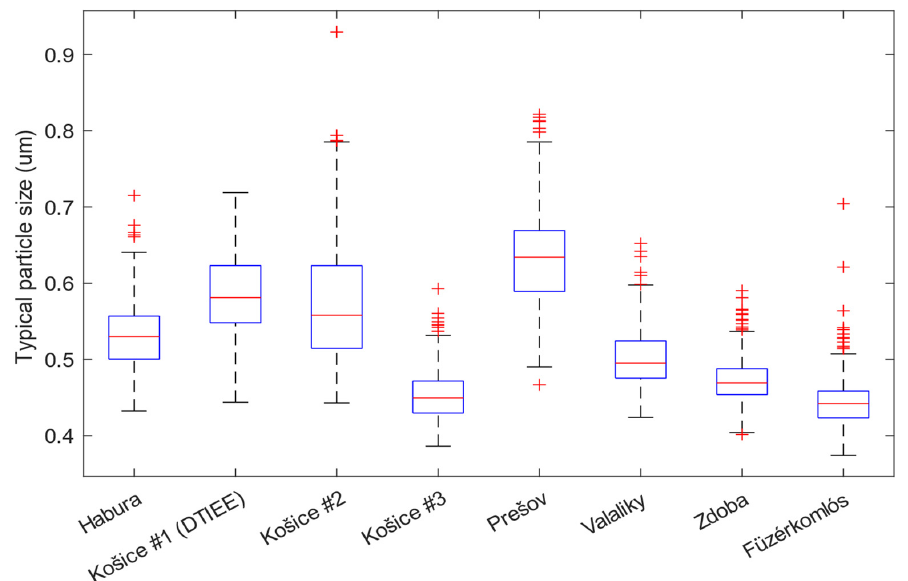
Figure 11. Box plot showing typical particle size in different locations: Habura, Košice #1 (DTIEE), Košice #2, Košice #3, Prešov, Valaliky, Zdoba, Füzérkomlós. The blue boxes contain values within the 25th to 75th percentile, the median is marked with a red horizontal line across the box, the dashed black vertical lines contain all data points not considered outliers, and the outliers are marked with a red plus sign (+). Table 3. Typical particle size by measuring site: interquartile range, median, minimum, and